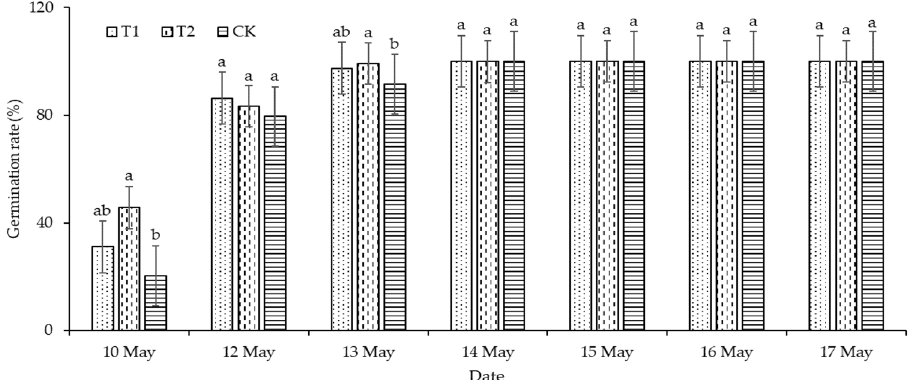
Figure 3. Germination rate of different treatment.